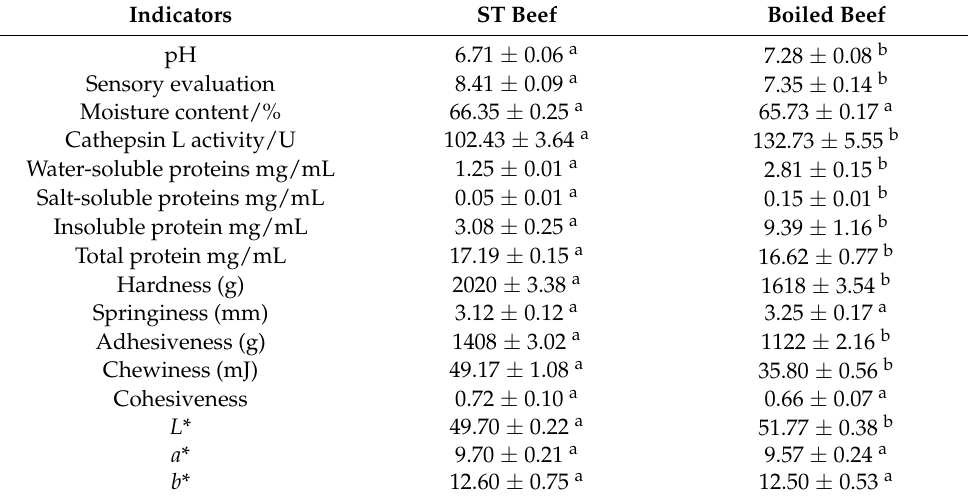
Table 5. Physicochemical properties of cooked beef.